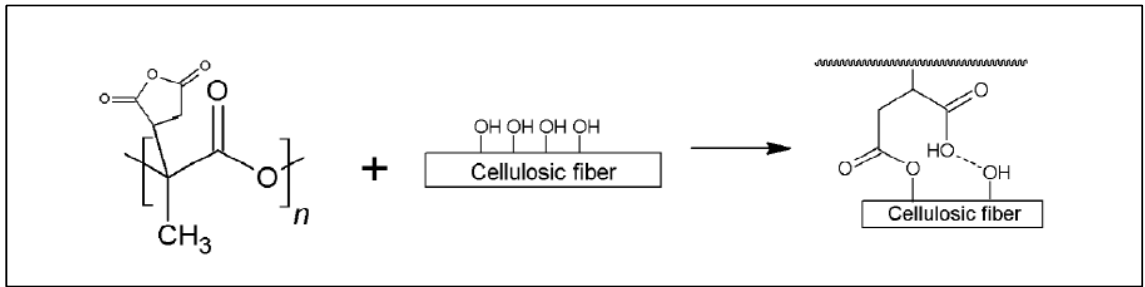
Figure 6. Reaction scheme for the grafting of a cellulosic fiber on PLA- g -MA (from González-López et al. [21], copyright Taylor and Francis, reproduced with permission).